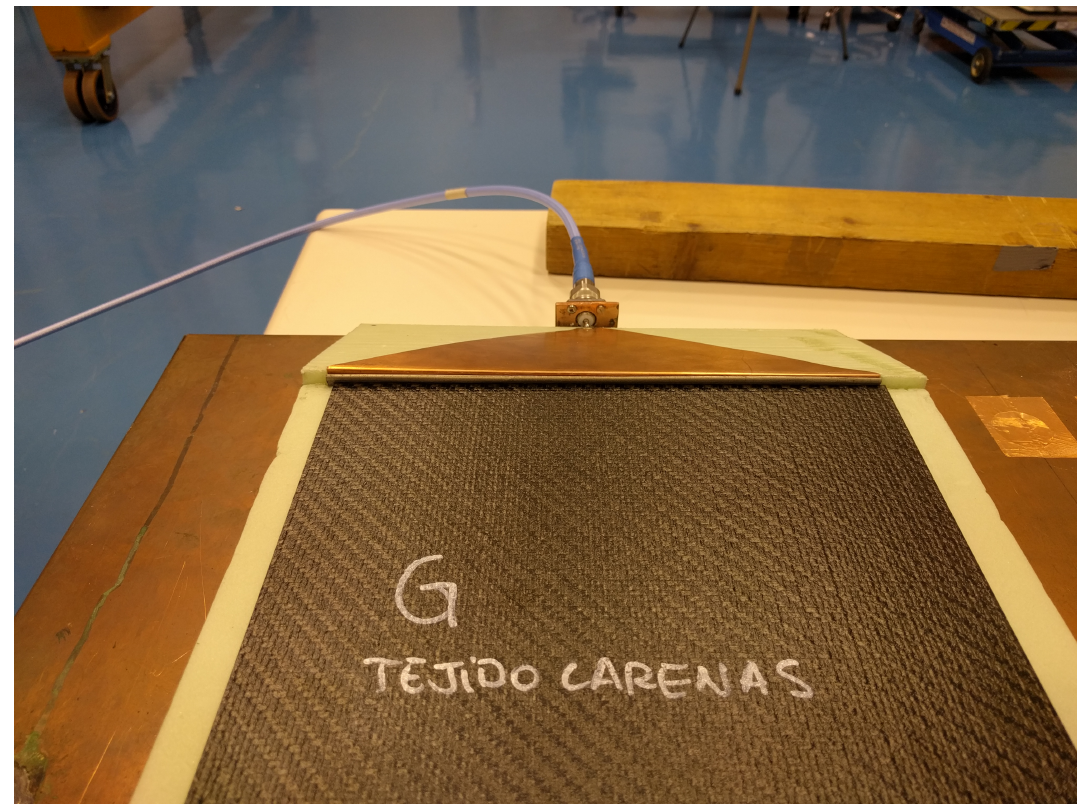
Figure 4. Metallic gasket to achieve a good connection between the triangular transition and the